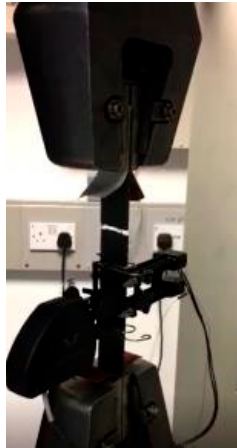
Figure 4. Composite samples under quasi-static loading with strain transducers.